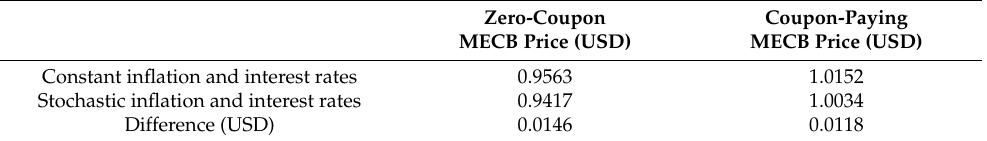
Table 5. The comparison of MECB prices with constant and stochastic inflation and interest